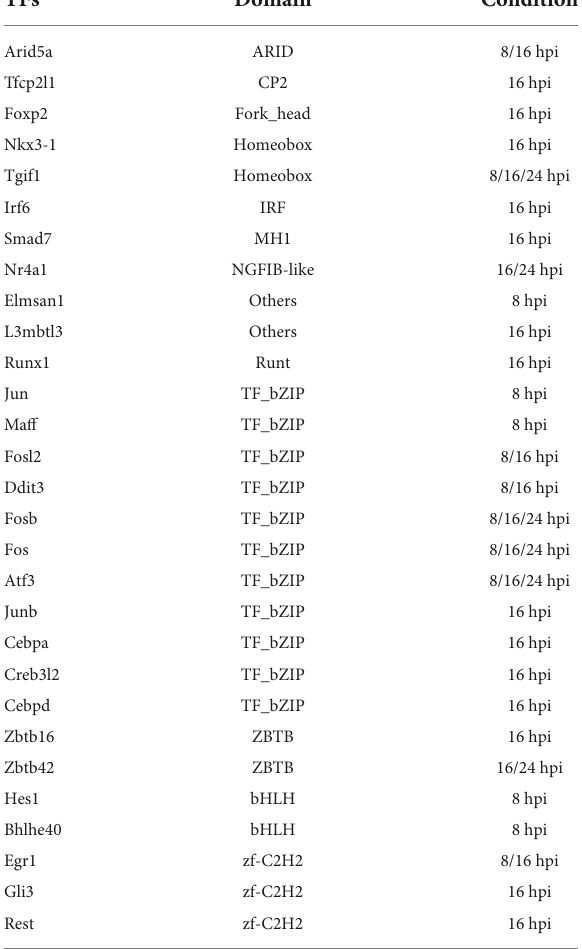
TABLE 1 TFs that were differentially upregulated at different hours after in vitro axon